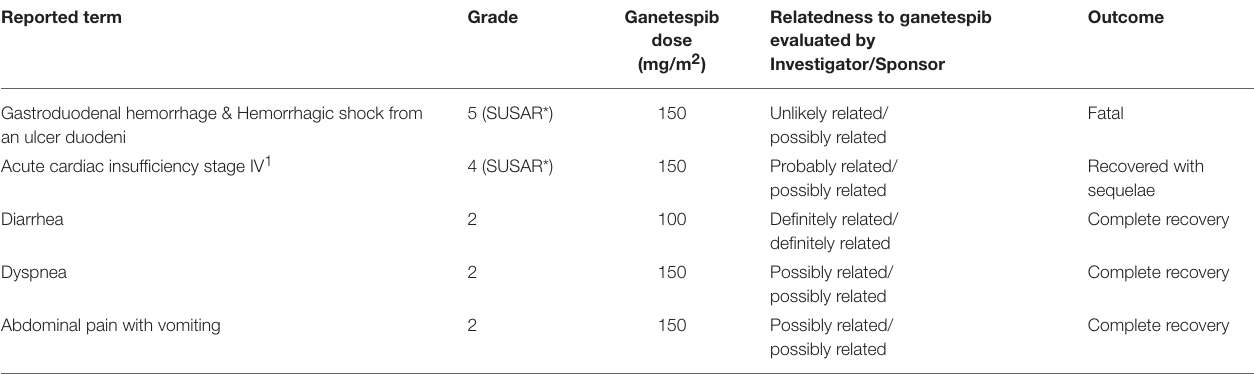
TABLE 4 | Serious adverse reactions (SARs). Reported term Grade Ganetespib